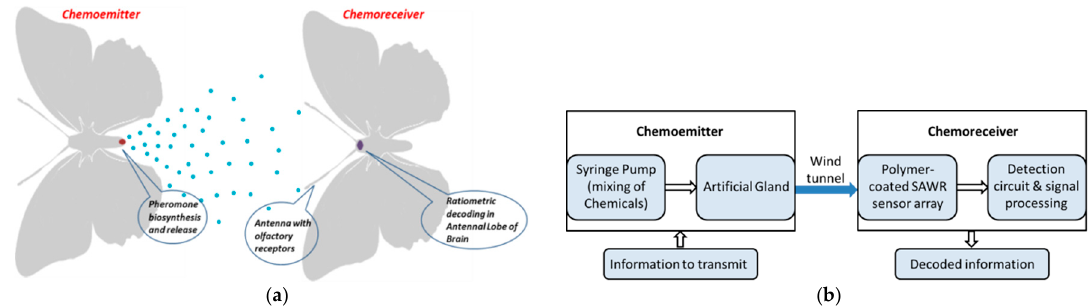
Figure 1. ( a ) Schematic diagram showing the relation between the primary biological components contributing to pheromone-based insect communication; and ( b ) the corresponding bio-inspired modules that form a possible configuration of a biosynthetic infochemical communication system with chemoemitter and chemoreceiver.